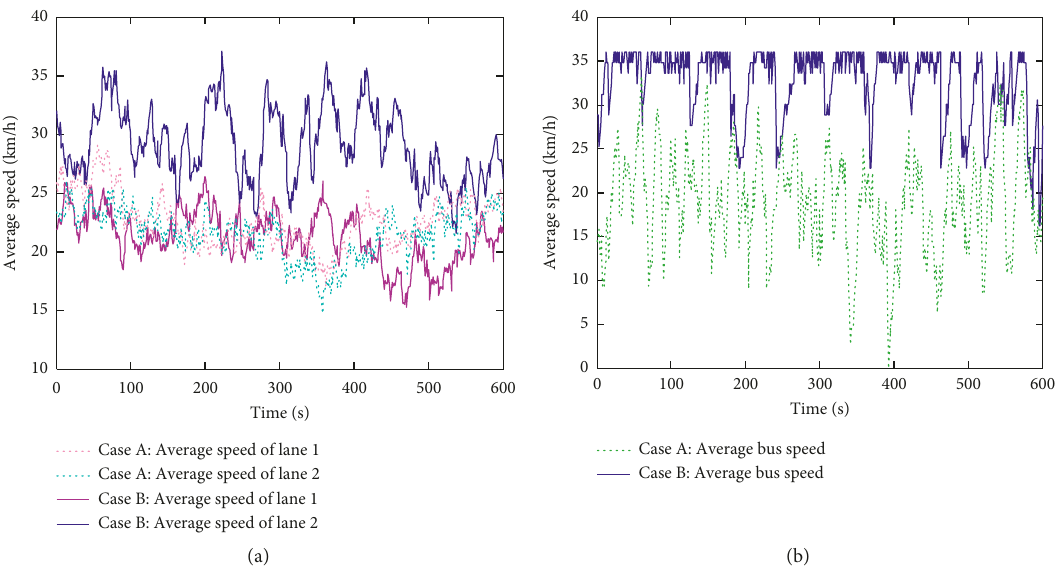
Figure 7: Average speed distributions of Group A and Group